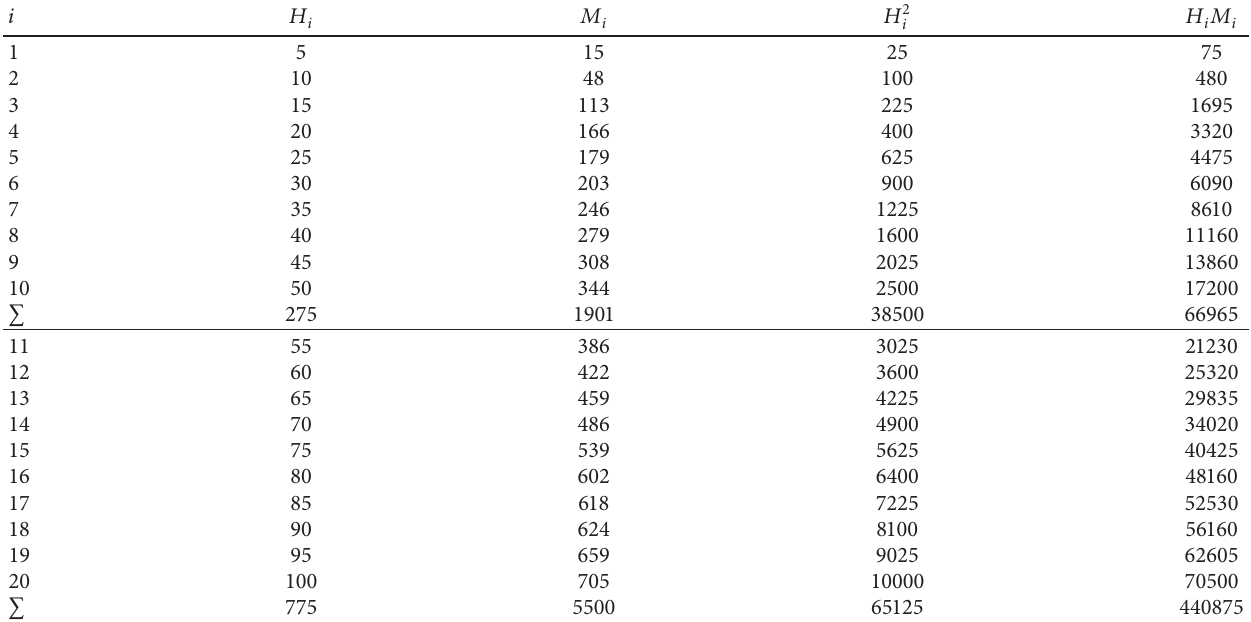
Table 6: Value of the magnetic field intensity and